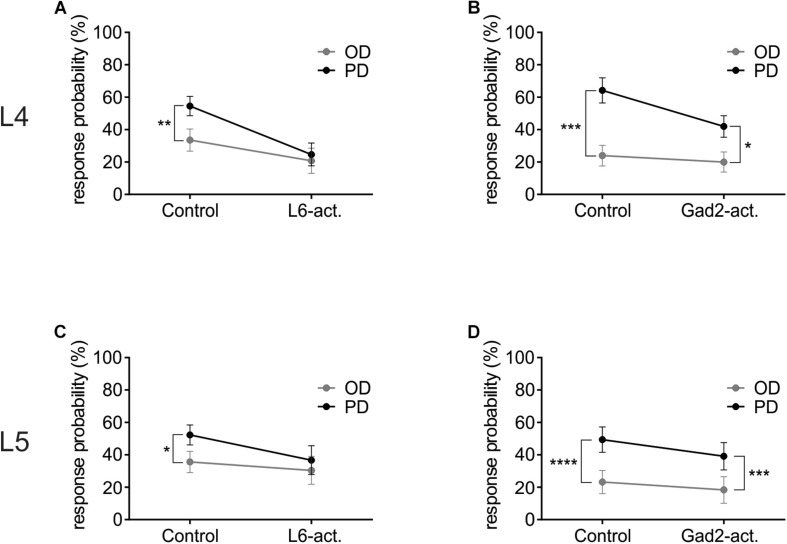
L6-Ntsr1 photoactivation, but not Gad2-activation caused the cells to be equally likely to respond to the preferred (PD) as the opposite direction (OD, 180° from the PD). (A) In L4 excitatory cells, with L6-Ntsr1 activation (n = 13), there was no difference in the response probability between PD and OD whisker deflection. (B) In contrast, for Gad2-activation (n = 12) the difference between PD and OD persisted even with photoactivation. (C,D) A similar result was found for L5 excitatory cells, where L6-Ntsr1 activation (n = 12), but not Gad2-activation (n = 12) abolished the difference in response probability between the PD and OD response. Stars (∗) refer to result from repeated measure two-way ANOVA and Sidak’s multiple comparison test.